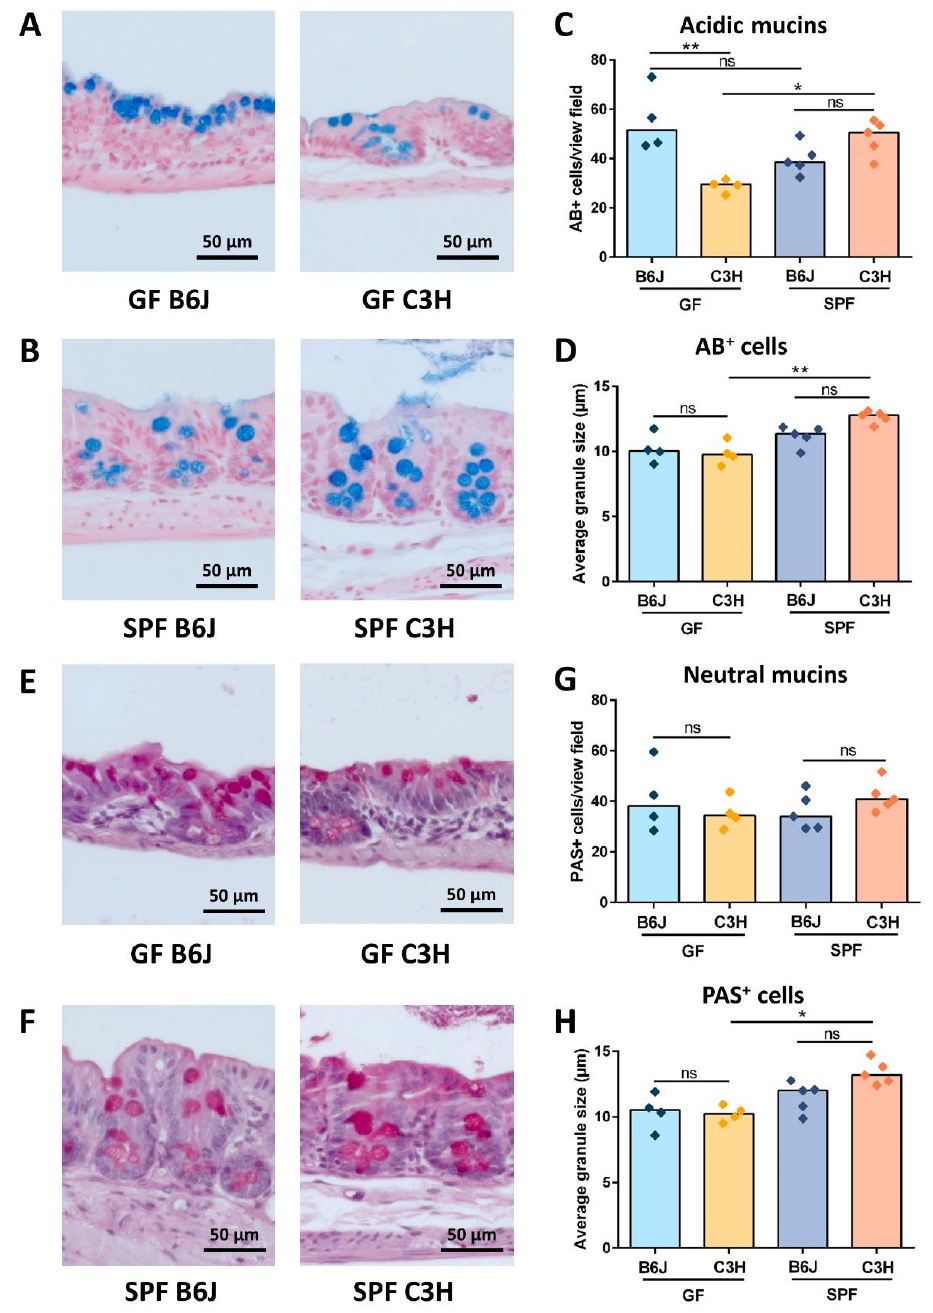
Figure 5. Contribution of mucins to the cecal enlargement. ( A – D ) Alcian blue staining: ( A,B ) Rep- resentative images of Alcian blue staining of ( A ) GF B6J and C3H and ( B ) complex microbiota colo- nized B6J and C3H cecal tissue. Acidic mucin-secreting goblet cells are stained blue. Nuclei (light